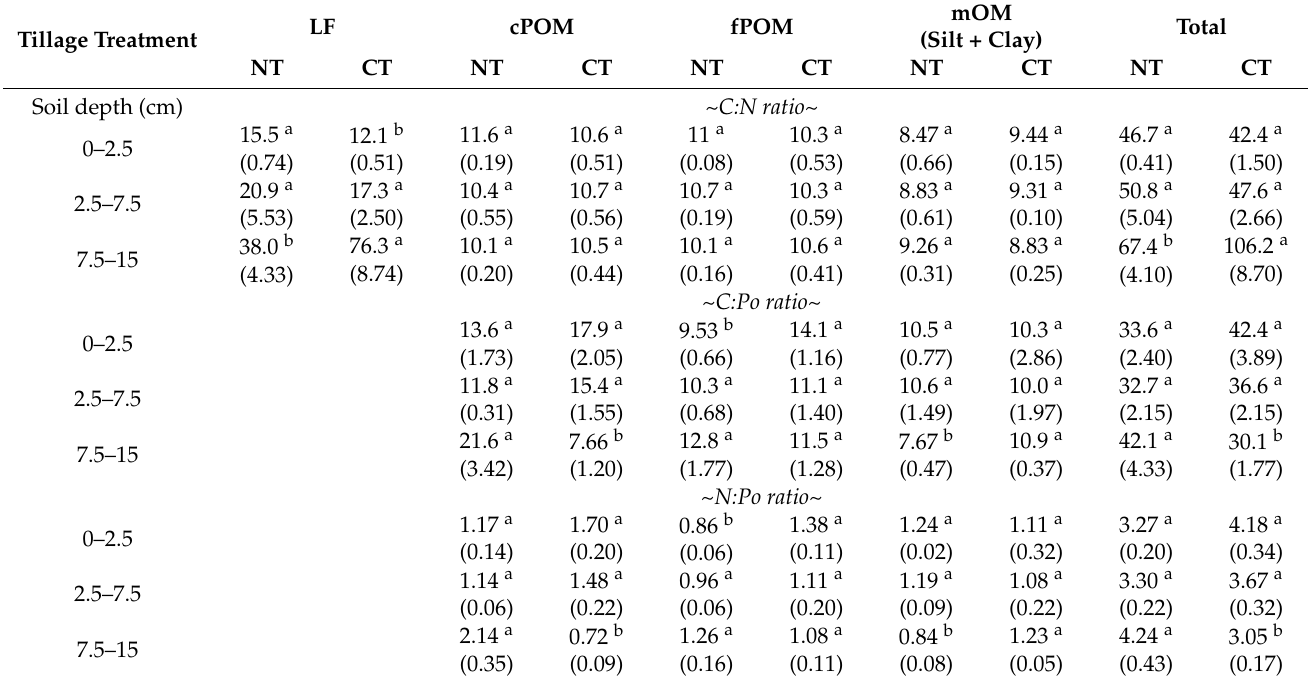
Table 2. C:N, C:Po, and N:Po ratios of each fraction by physical fractionation of Andosols from